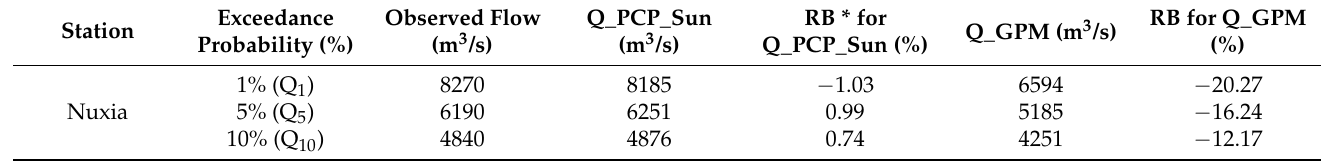
Table 9. Statistics of the simulated flood events at the two hydrological stations in the